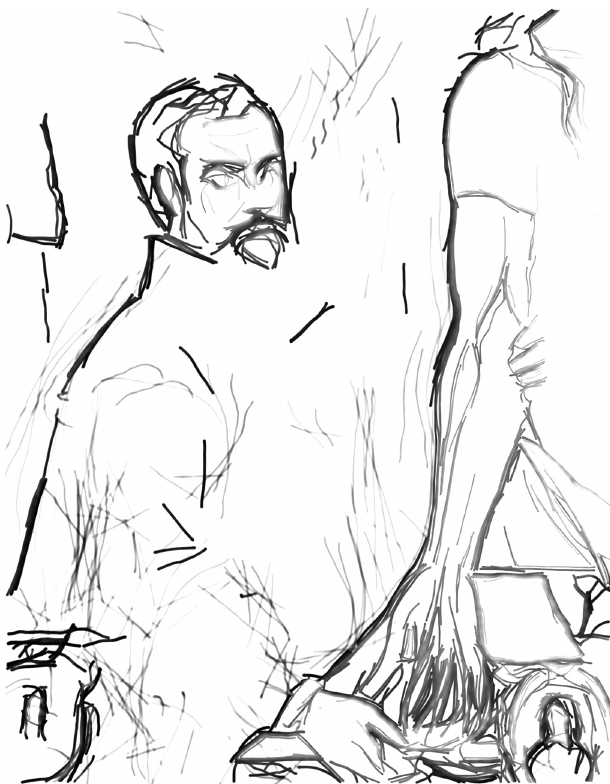
Fig. 1 - Painting showing Andreas Vesalius in his dissection activity (Adapted [11]